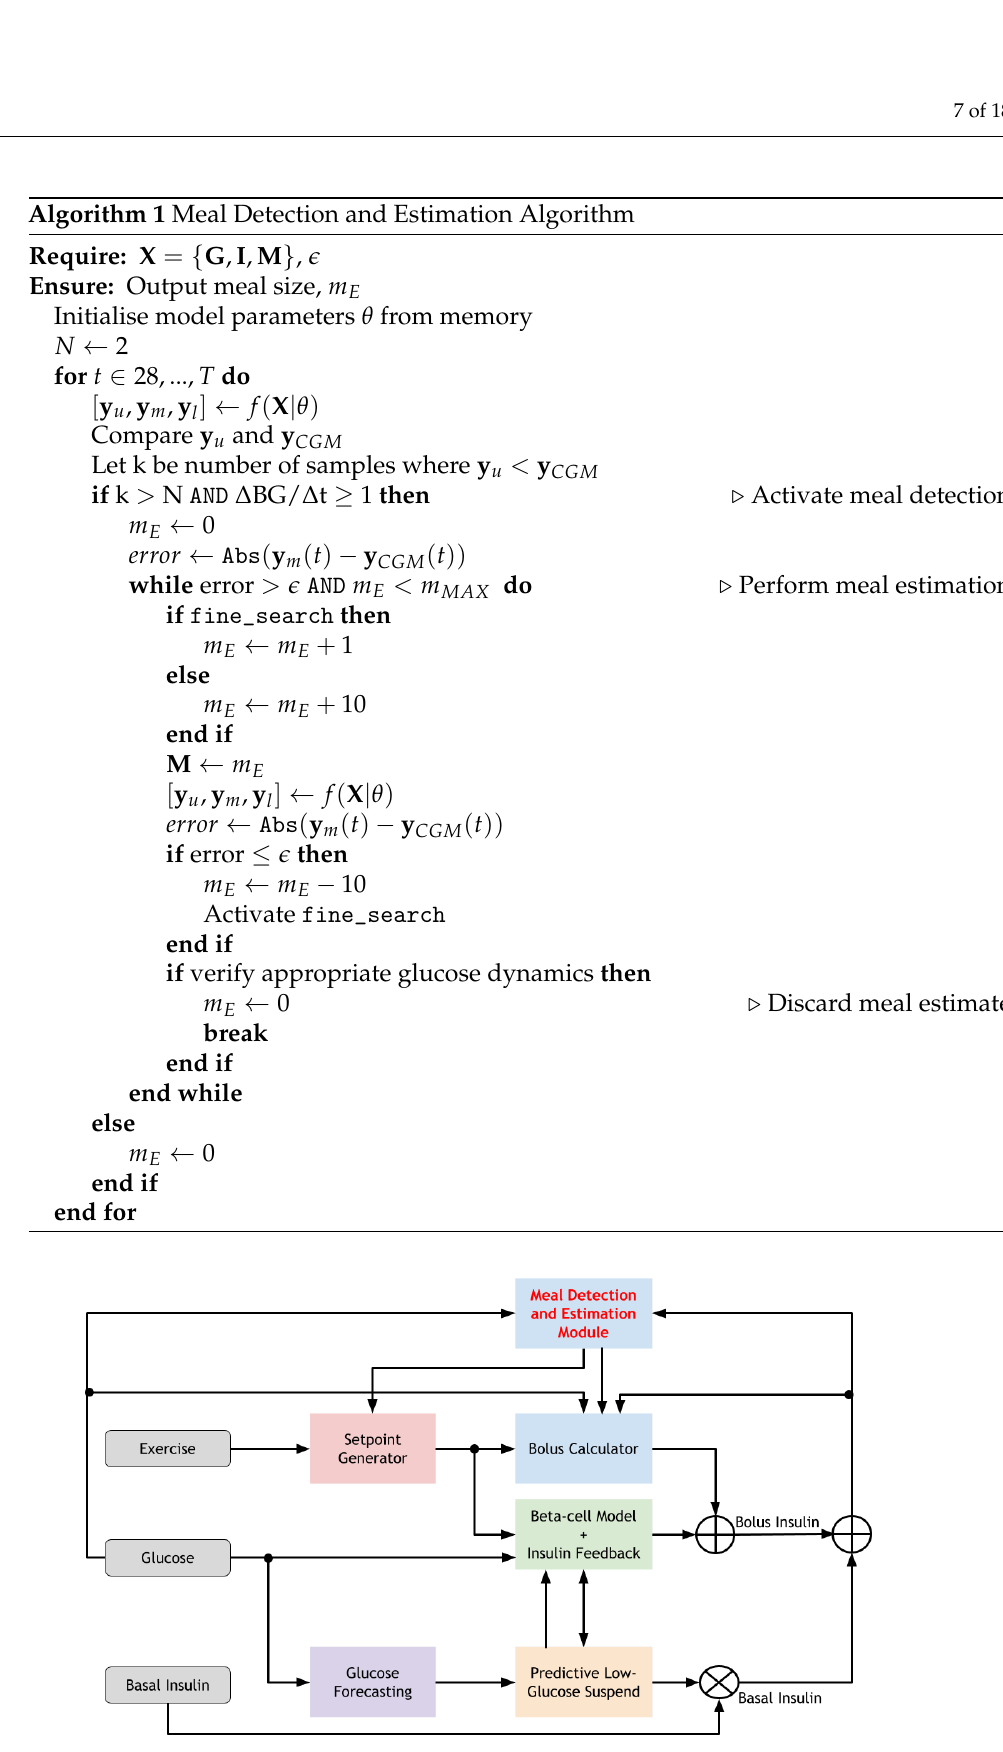
Figure 3. The system architecture of the bio-inspired artificial pancreas with the meal detection and estimation algorithm